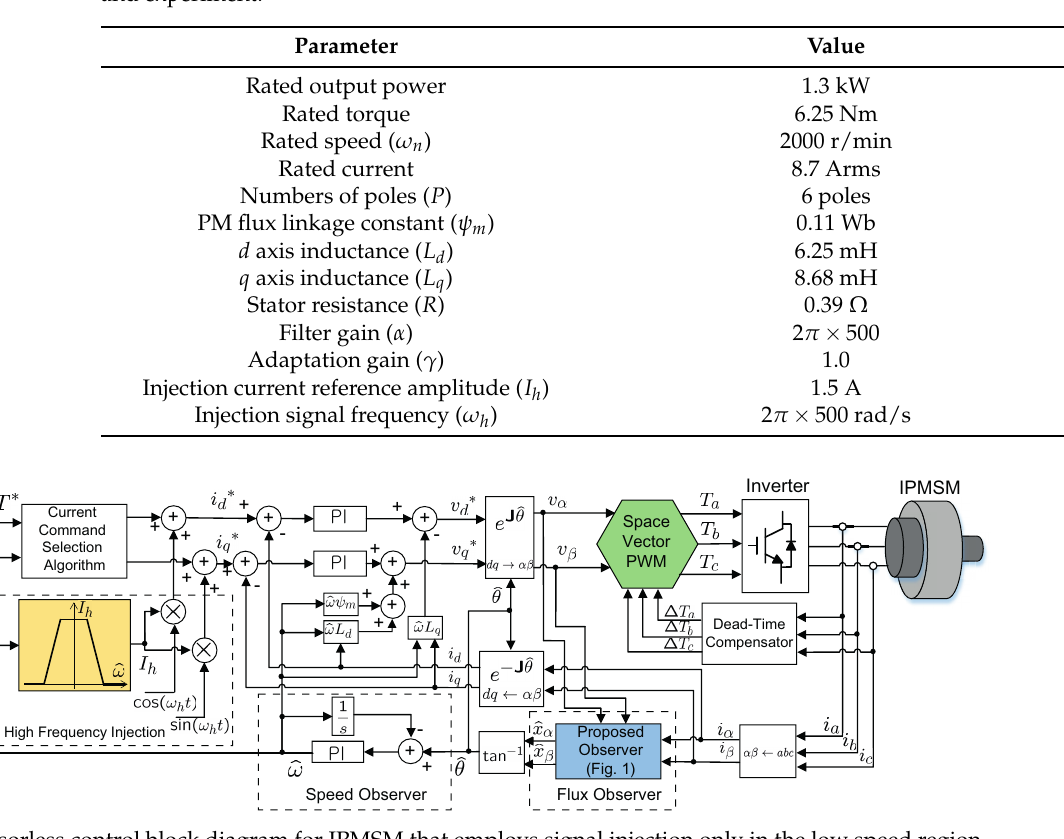
Table 2. Parameters of an interior PMSM and gains of the proposed observer used in the simulation and experiment.